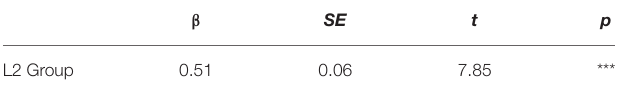
TABLE 7 | Model of both L1 + L2 data on segment 6 (Experiment